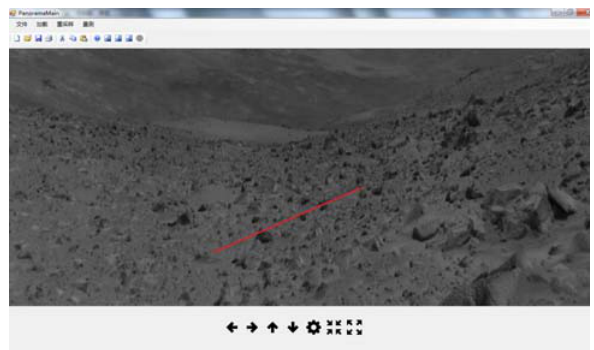
Figure 6. Measuring a profile in the panorama